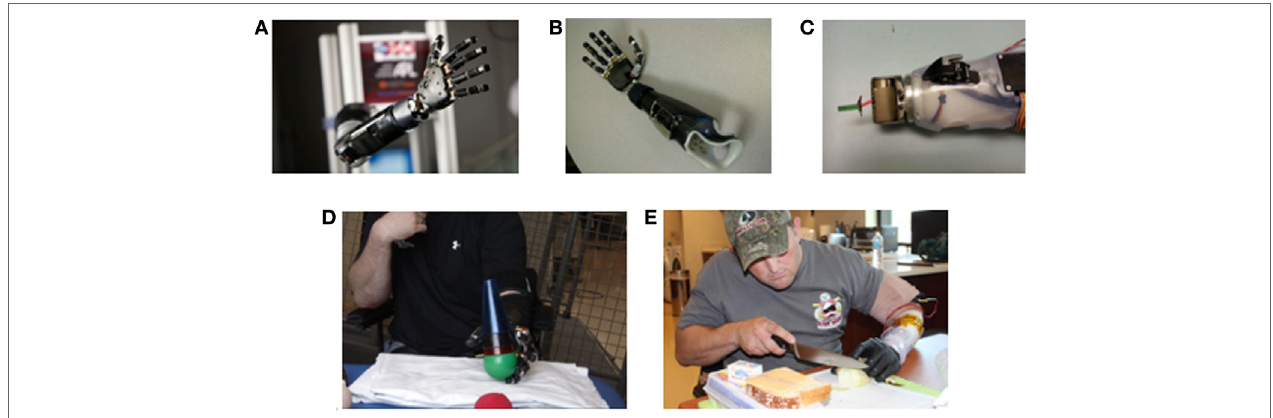
FIguRe 1 | Images of Modular Prosthetic Limb (MPL) fitting and training by users with upper limb amputation. (a) The MPL configured at shoulder level with integration of all sensory, motor, and control capabilities. (B) The trans-radial MPL configuration for TR01. (C) The modulation of the MPL wrist to one degree of freedom for TR02 to support proper anatomical arm length and facilitate completion of activities of daily living. (D) TR01 performing reach, grasp, and manipulation tasks during a clinical use session. (e) TR02 performing a cooking task at Walter Reed National Military Medical Center in Bethesda, MD,